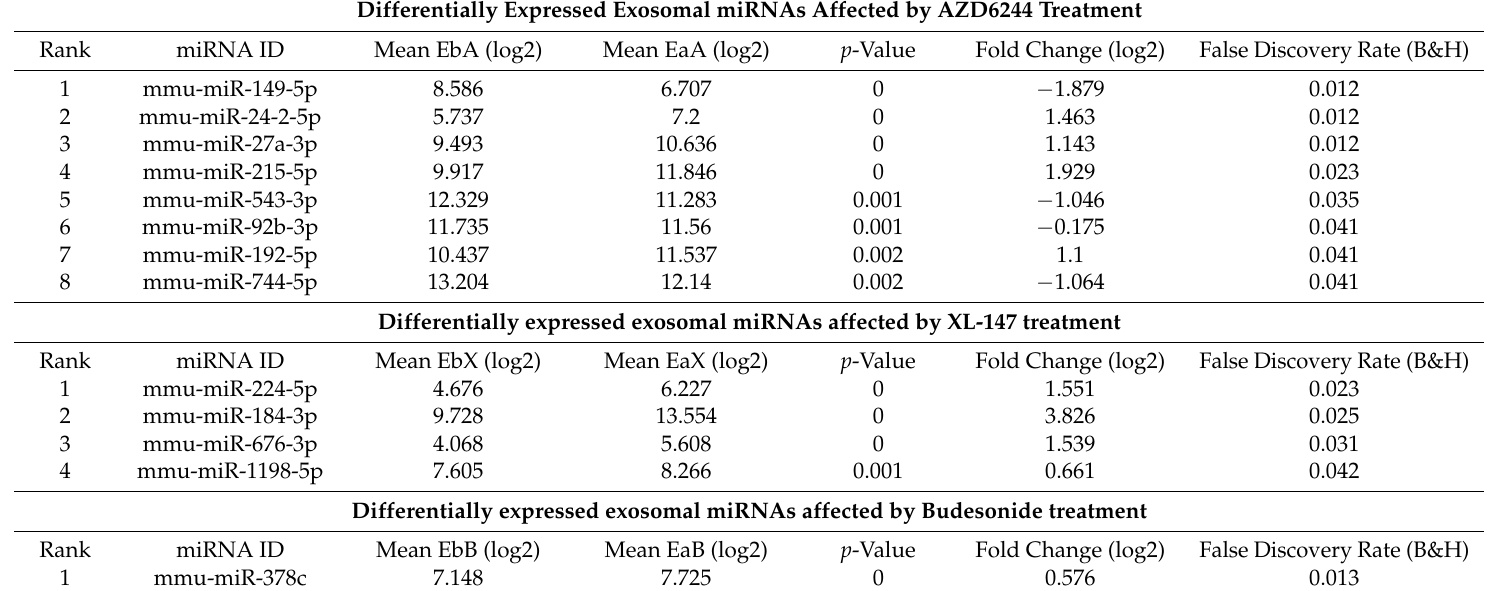
Table 2. Differentially expressed exosomal miRNAs affected by cancer chemopreventive agent